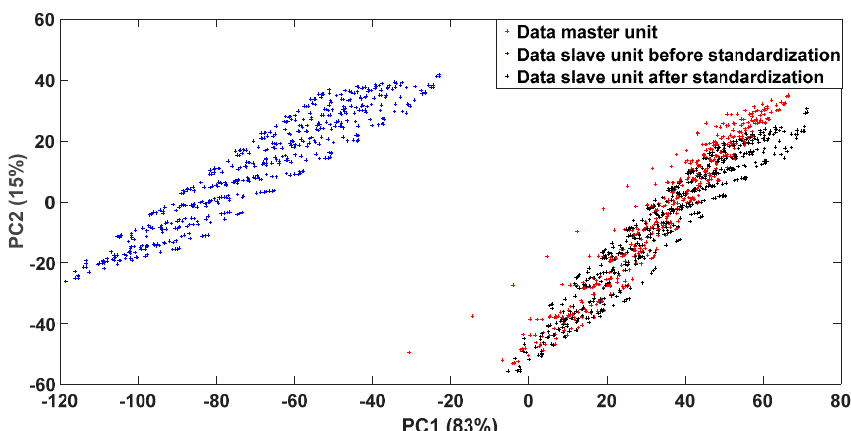
Figure 4. Principal component analysis (PCA) projection of the data captured with unit 1 and signals from unit 2 before and after standardization.